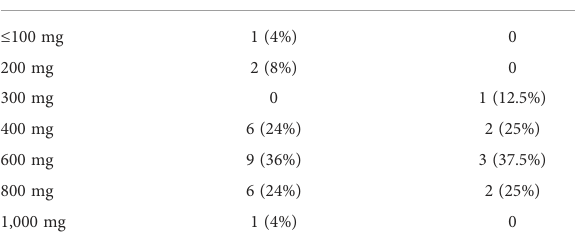
TABLE 4 Final dose of ketoconazole used in patients with Cushing ’ s disease. Final dose